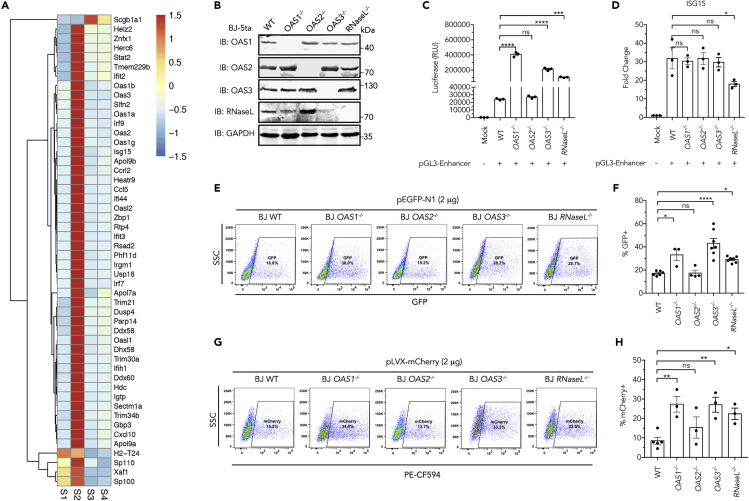
The OAS-RNaseL System Suppresses Transgene Expression(A) Heatmaps of RNA-seq analyses. S1, L929 cells mock-treated; S2, L929 cells transfected with pEGFP-N1 plasmid; S3, L929 treated with 0.5 μM BX795; S4, L929 treated with 0.5 μM BX795 and transfected with pEGFP-N1 plasmid. All samples were collected after 6 h. Color gradient indicates fold changes in log2 scale. Genes in sample S2 exhibiting statistically significant (p < 0.05), two-fold or greater increases over S1, S3, S4 are shown.(B) Western blot of indicated proteins in wild-type, OAS1−/−, OAS2−/−, OAS3−/−, or RNaseL−/− (CRISPR-Cas9) BJ-5ta cells.(C) Luciferase activity in extracts from indicated wild-type or CRISPR-Cas9 knockout cell lines 24 h after transfection of pGL3-Enhancer plasmids.(D) Expression levels of ISG15 as measured by RT-qPCR 8 h after transfection of indicate BJ-5ta cells with pGL3-Enhancer plasmid.(E−H) BJ-5ta cells of indicated genotypes were transfected with pEGFP-N1 plasmid (E) or pLVX-mCherry (G) using lipofectamine method; 24 h later, fluorescence-positive cells were analyzed by FACS. (F) and (H) are quantification of GFP- or mCherry-positive cells in (E) and (G), respectively.In (C), (D, (F), and (H), data represent mean ± SEM of ≥3 independent experiments. ∗p < 0.05, ∗∗p < 0.01, ∗∗∗p < 0.001, ∗∗∗∗p < 0.0001 (one-way ANOVA, with Dunnett's correction). Ns, not significant (significance level, α = 0.05). See also Figures S5 and S6.